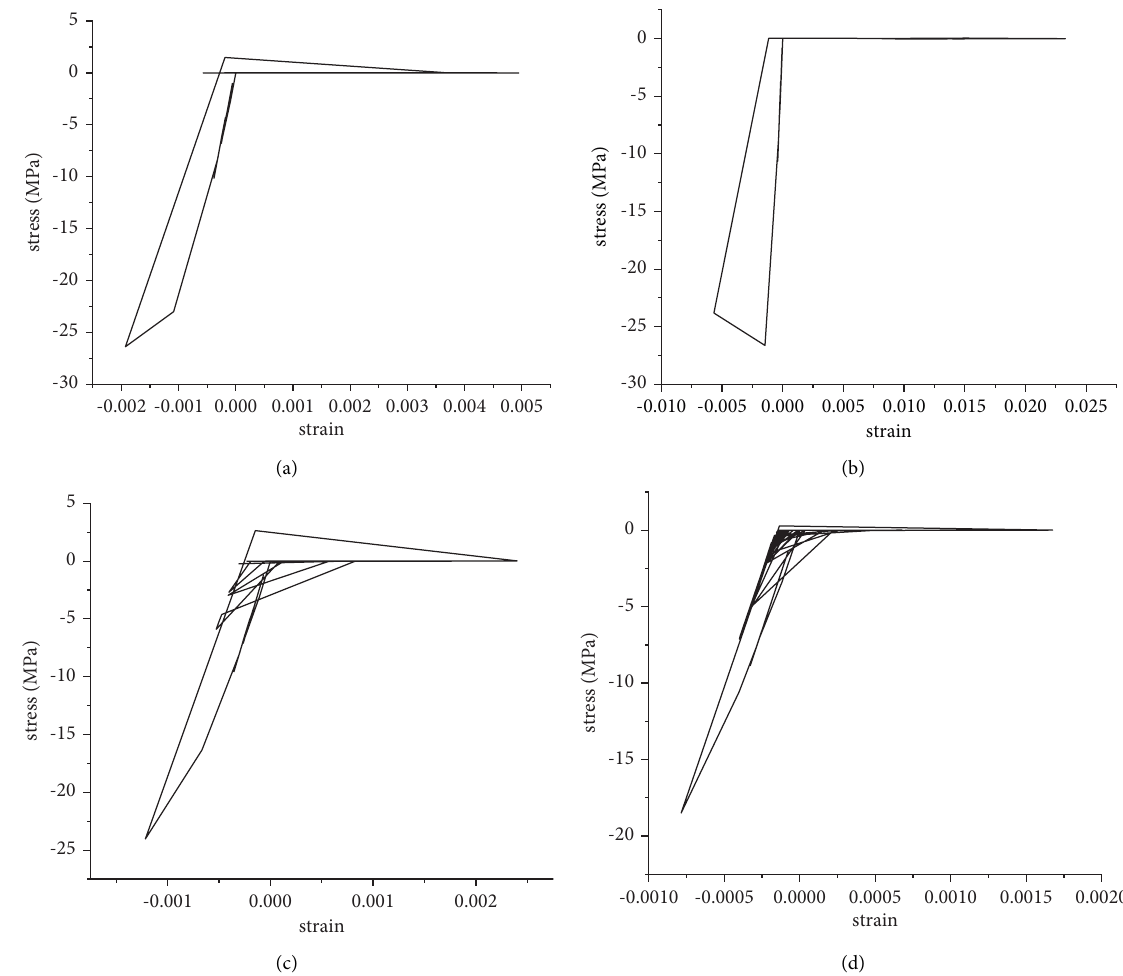
Figure 25: Stress-strain curves of concrete units at diferent positions under working condition 3. (a) Stress-strain curve of concrete at bottom of left pier. (b) Stress-strain curve of concrete at top of left pier. (c) Stress-strain curve of concrete at bottom of middle pier. (d) Stress-strain curve of concrete at top of middle